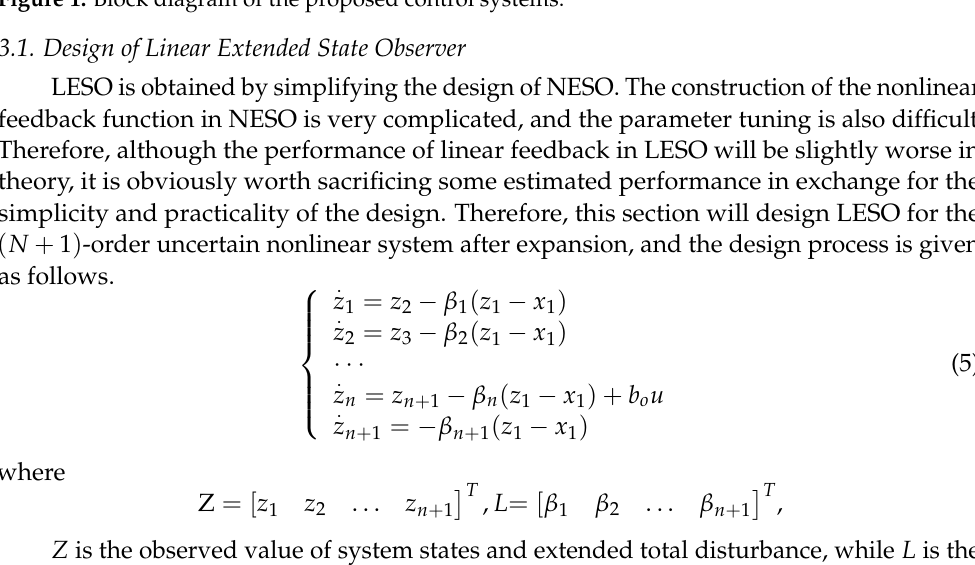
Figure 1. Block diagram of the proposed control systems.